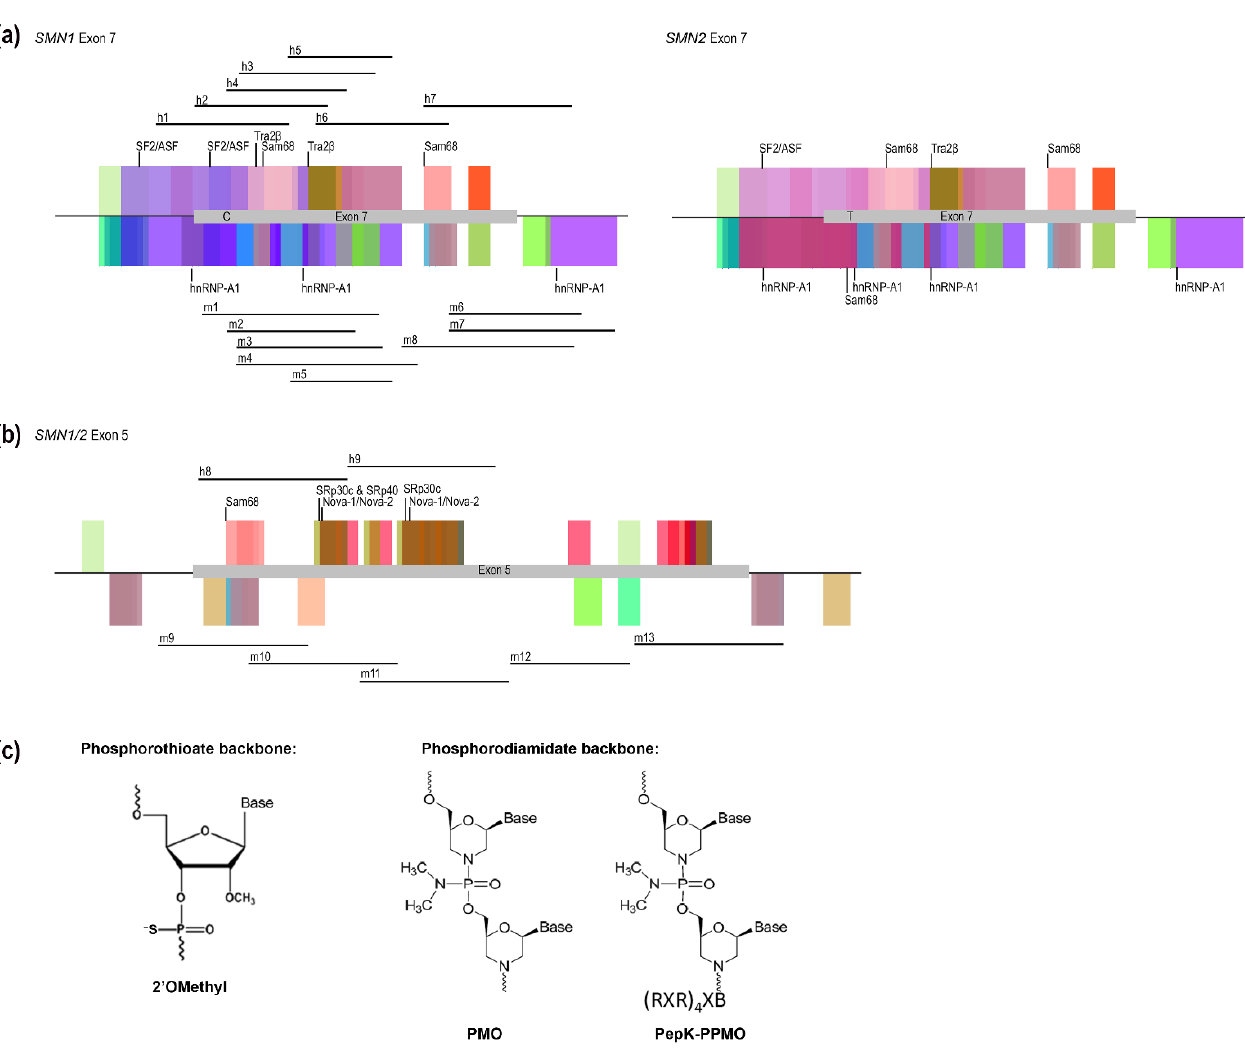
Figure 1. ( a ) schematic of SMN1 and SMN2 exon 7 SpliceAid predicted splicing factor binding sites with the more strongly predicted splicing factors labelled, including alternative splicing factor/pre-mRNA splicing factor 2 (ASF/SF2) and transformer 2 Beta (Tra2 β ) as positive exonic splicing enhancer elements, and SRC associated in mitosis of 68 kDa (Sam68) and heterogenous nuclear ribonucleoprotein A1 (hnRNP-A1) as negative exonic splicing silencer elements. The binding location of the human exon 7 skipping AOs are indicated above the SMN1 exon 7, and the homologous mouse Smn exon 7 skipping AOs are indicated below; ( b ) schematic of SMN1/2 exon 5 predicted splicing factor binding sites, with the more strongly predicted splicing factors labelled, including Sam68, serine and arginine rich splicing factors (SRp-30c and SRp-40) and the Nova-1 and Nova-2 proteins as exonic splicing enhancers. The human and mouse exon 5 skipping AOs are indicated above and below the schematic, respectively; and ( c ) the chemical structure of the three AO chemistries used in this study, including the 2′- O -methyl phosphorothioate AO, the PMO and the PepK-conjugated PPMO, adapted from [27,28].